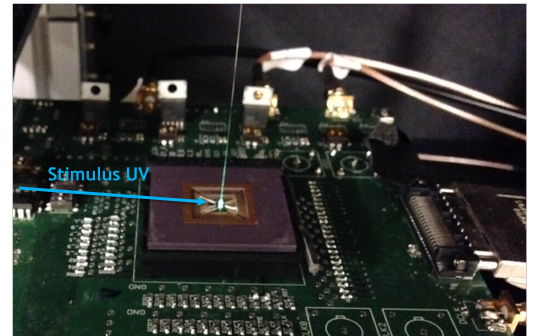
Figure 13. Measurement setup for on-chip 3D localization and fluorescence lifetime